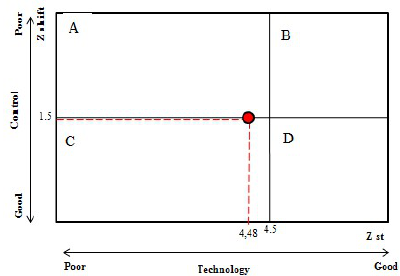
Fig. 5. Four block diagrams of sigma level of current